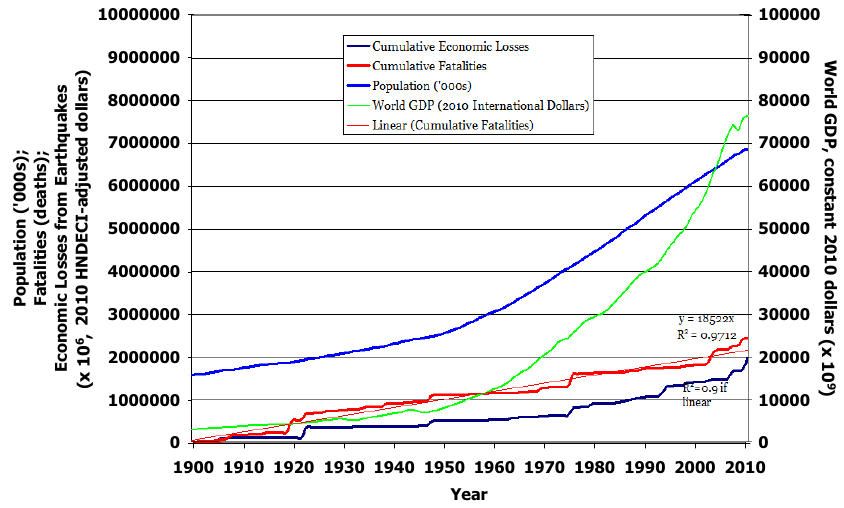
Fig. 17. Economic Losses (2011 Hybrid Natural Disaster Economic Conversion Index adjusted) for 7000+ earthquakes from the year 1900– 2011 worldwide (Daniell,